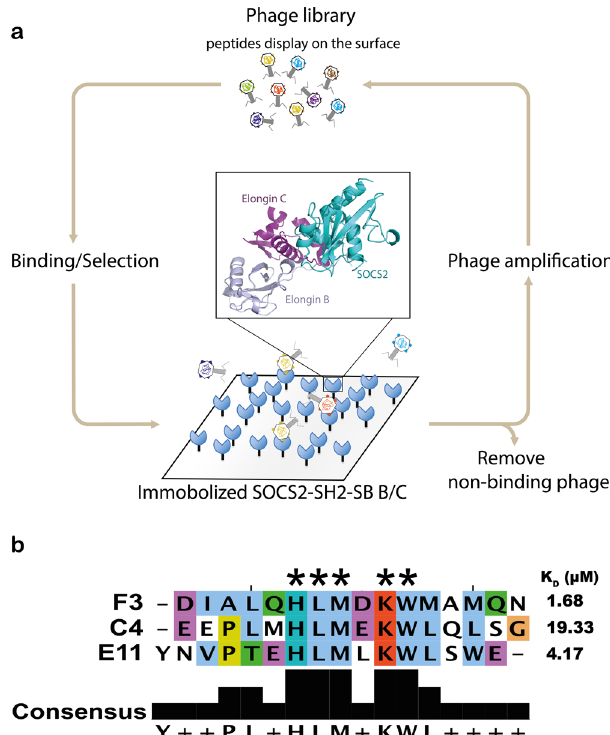
Fig. 1 Identi fi cation of a peptide that binds with low micromolar af fi nity to the SOCS2/Elongin B/C complex. a Phage display of a degenerate peptide library was used to enrich for non-phosphorylated peptides that bound to SOCS2. GST-SOCS2-SH2-SOCS box protein was produced as a trimeric complex in E. coli by co-expression with elongins B and C. Protein was produced with an N-terminal GST tag and lacks the SOCS2-N-terminal region [GST-SOCS2 32 – 198 -EloB/C]. b Three peptide sequences that shared amino-acid sequence homology were enriched by phage display. Colors indicate amino-acid similarity. *indicates mutation to Ala = loss of binding. ITC was used to determine the binding af fi nities ( K D ) of the individual peptides (shown on the right) (related to Table 1). Table 1 Mutation of F3 peptide impacts on binding to SOCS2.